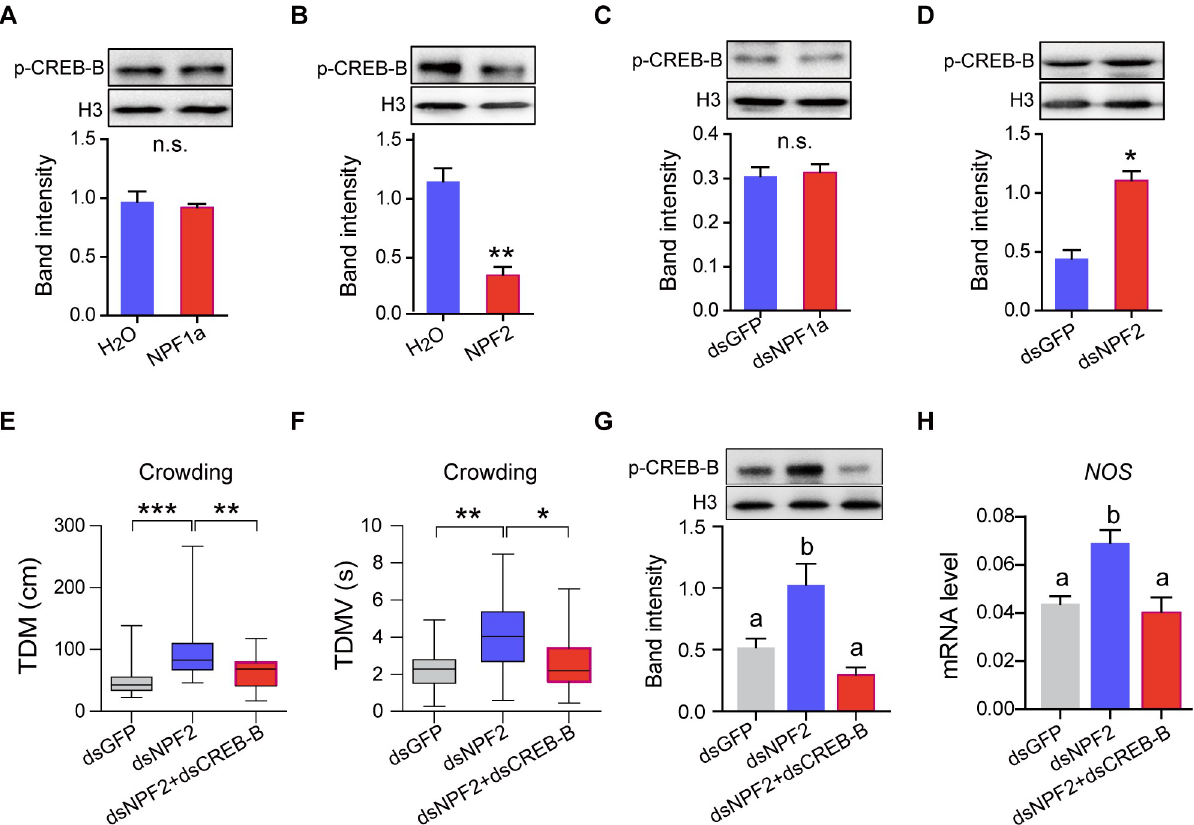
Fig 5. CREB-B modulates phase-related locomotor activity under NPF2 regulation. (A) and (B) Effects on p-CREB-B level after injection NPF1a or NPF2 peptide in G-phase locusts. (C) and (D) Effects on p-CREB-B level after transcript knockdown of NPF1a or NPF2 in S-phase locusts (n = 4 replicates, 8–12 locusts/replicate, � P < 0.05, �� P < 0.01 with Student’s t-test). (E) TDM and (F) TDMV in crowded (16 h) S-phase locusts after dual- knockdown of NPF2 and CREB-B genes in crowded (16 h) S-phase locusts (n � 20 locusts, � P < 0.05, �� P < 0.01 with Student’s t-test). (G) p-CREB-B level and (H) NOS transcription level after dual-knockdown of NPF2 and CREB-B genes in crowded S-phase locusts (n = 3 replicates, 6–8 locusts/ replicate, one-way ANOVA, P < 0.05).